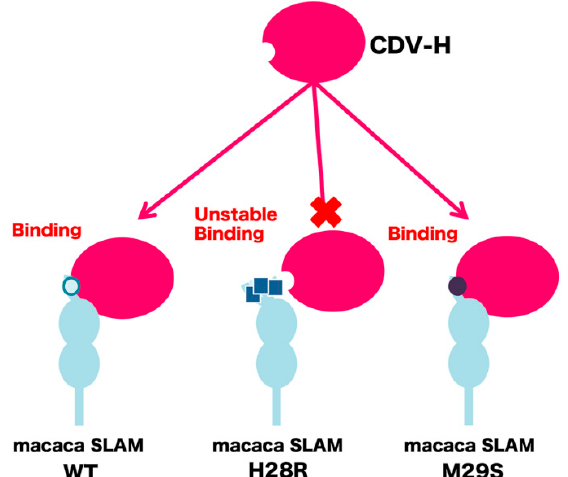
Figure 4. Schematic showing how key residues in the N -terminal region of macaca SLAM contribute to the interaction with CDV-H.